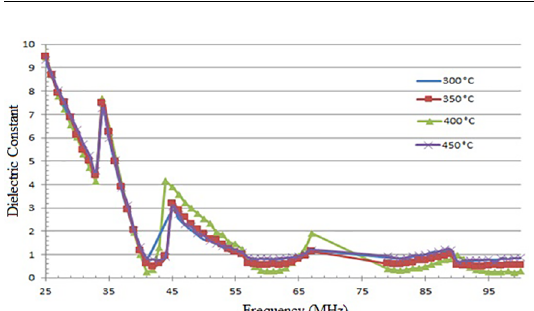
with different annealing 3